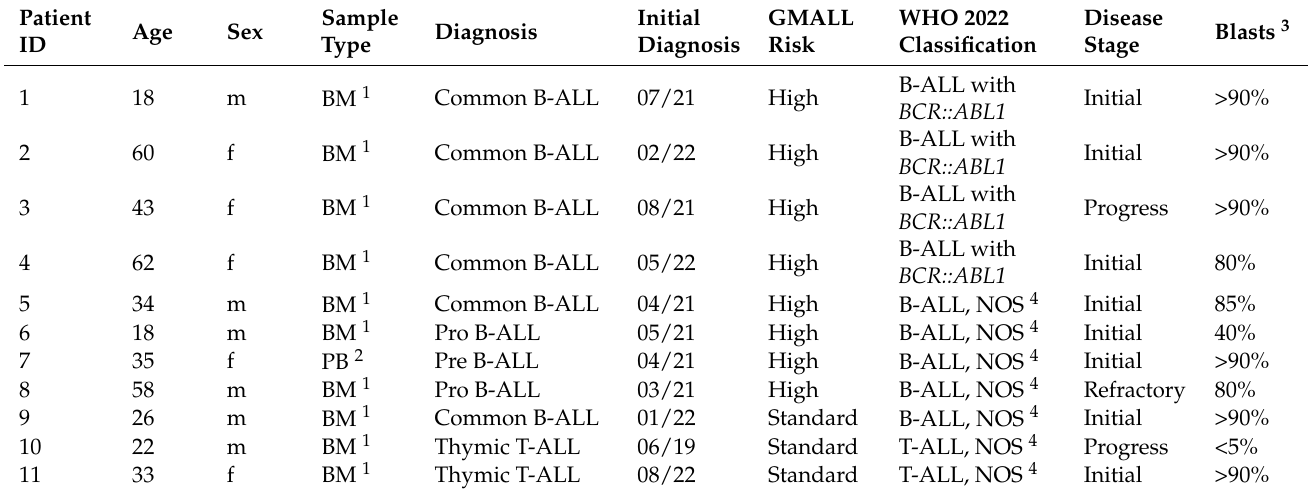
Table 1. Patient characteristics. f: female, m: male; 1 bone marrow aspirate, 2 peripheral blood, 3 BM infiltration (Histology) or blastcount in PB (cytology), 4 not otherwise